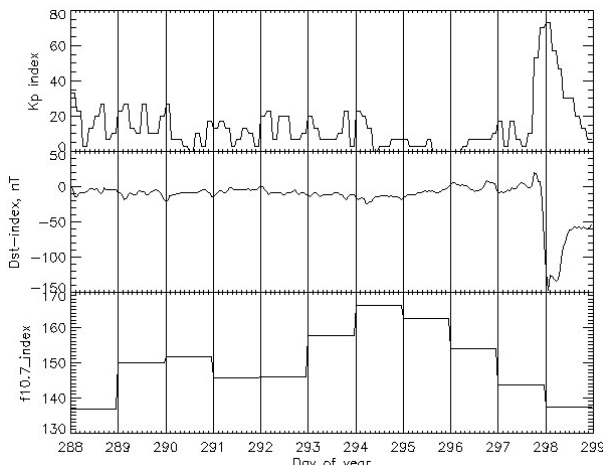
Figure 2. (Kp · 10), DsT, and F10.7cm index variation from 288 to 299 in 2011 (https://omniweb.gsfc.nasa.gov/form/dx1.html,